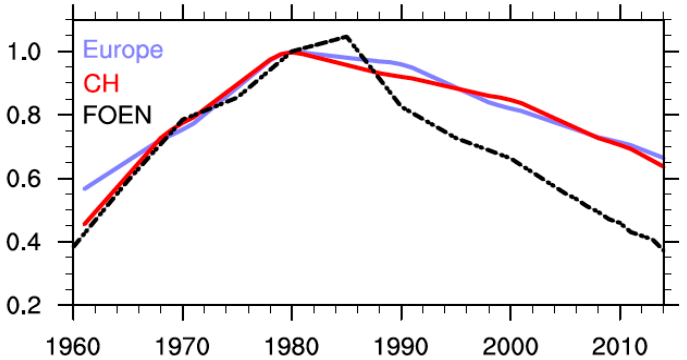
Figure 7. Time series of historical (1960 to 2014) NO x emissions for Europe (blue) and Switzerland (red) as used in the SOCOLv3 simulations compared to NO x emissions reported by the Swiss Federal Office for Environment (FOEN, dashed black [72]). All values are shown relative to the year 1980.